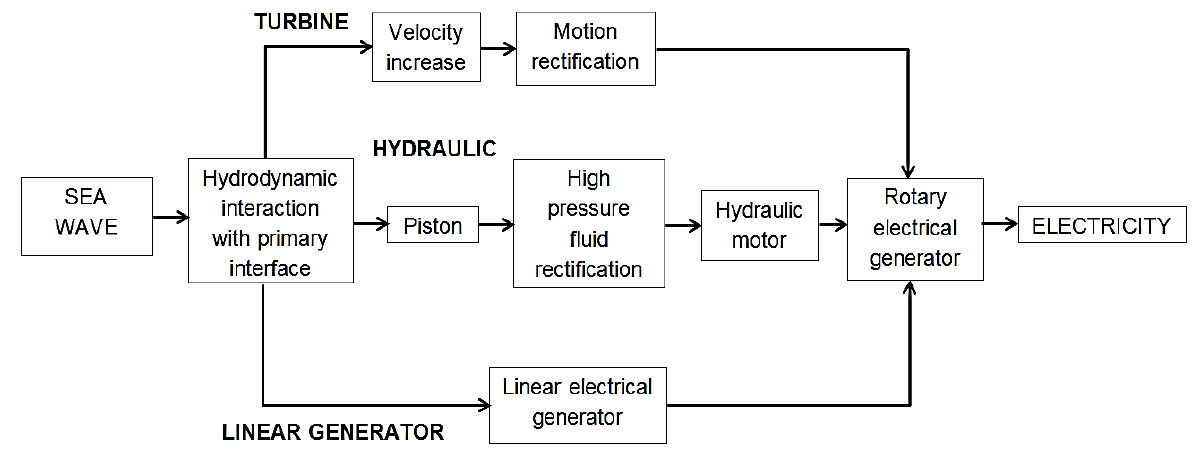
Figure 1. Working process of different WEC types.